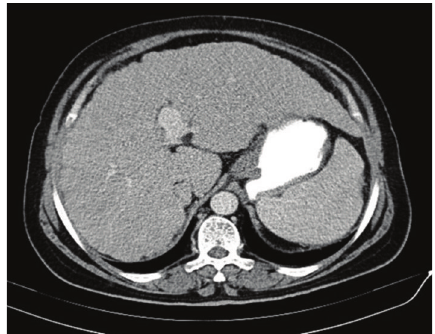
Figure 4: Abdominal CT scan showed complete absorption of asci- tes one month after